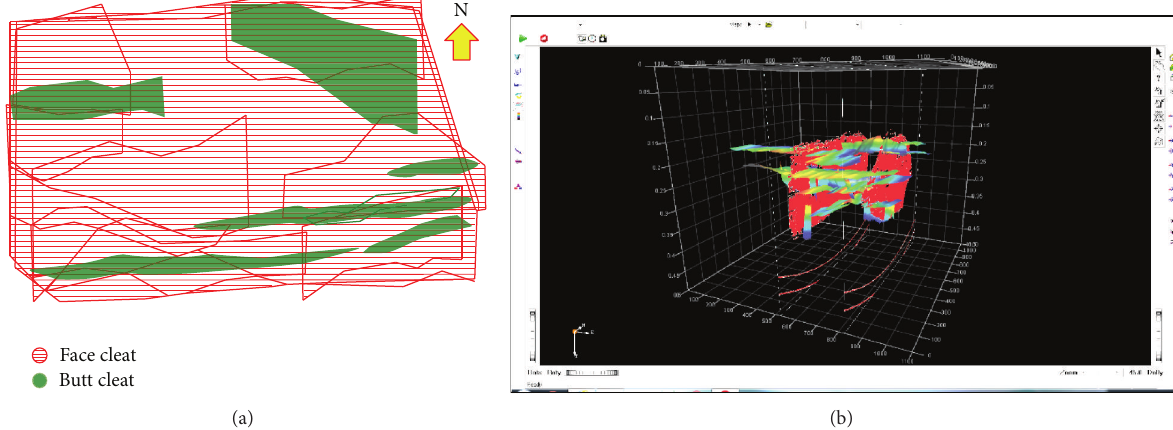
Figure 6: Illustrating 3D reconstruction of the cleats direction (a) from slice image of MNH-1A ( 𝑧 -axis direction); 3D rendering CT scan of MNH-1A (b). Face cleats have NNE-SSW direction (red color and gradational color), and butt cleats have NW-SE direction (green color and solid